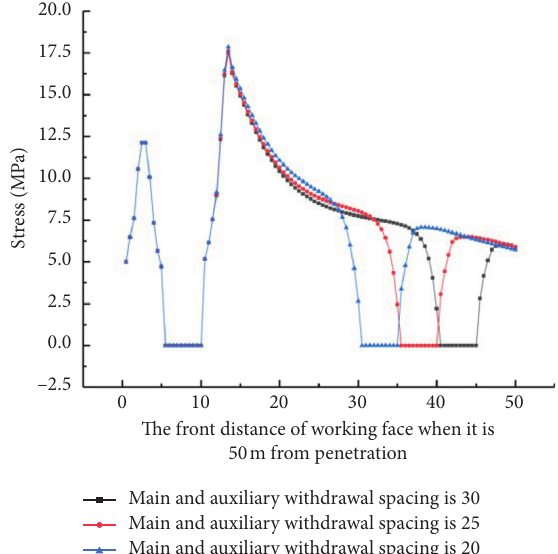
Figure 18: Vertical stress curve when Panel 31113 is 5 m from